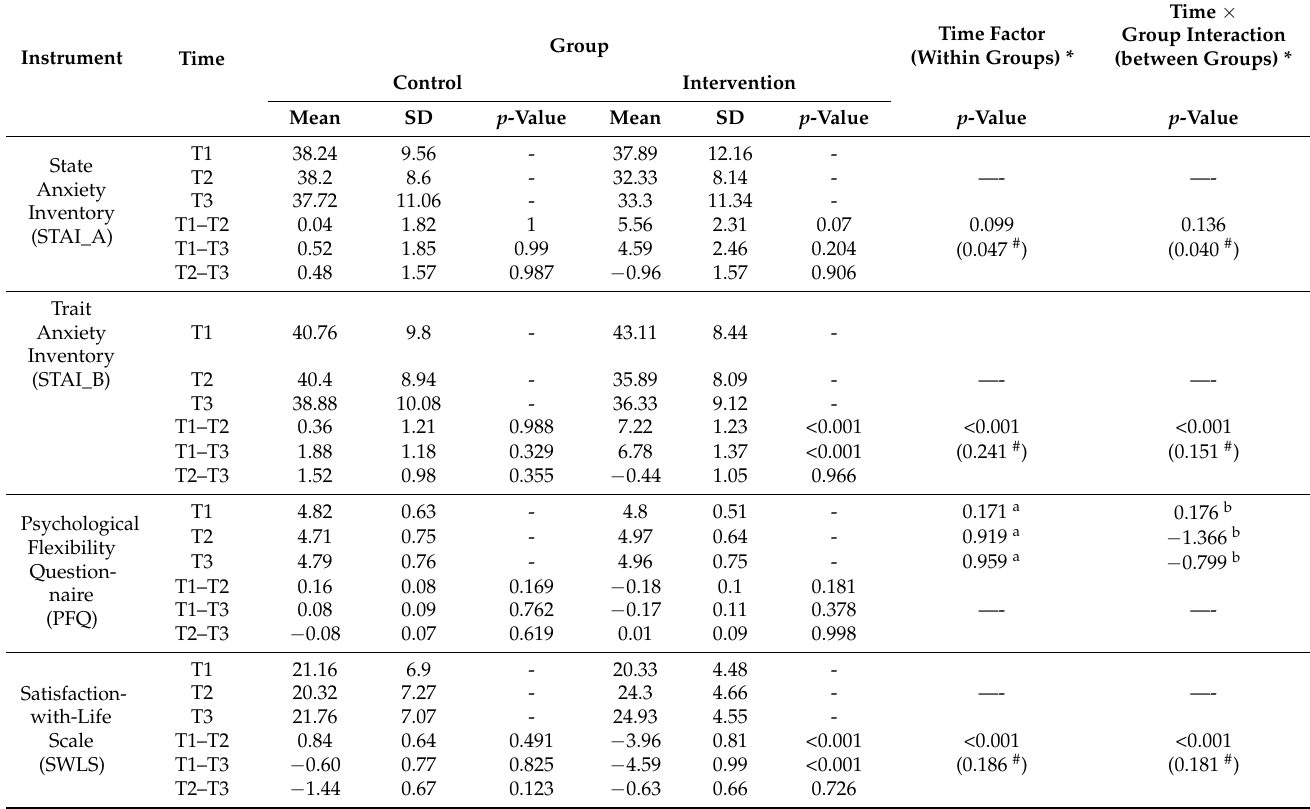
Table 3. Psychological outcome measures—comparing IBSR intervention with control